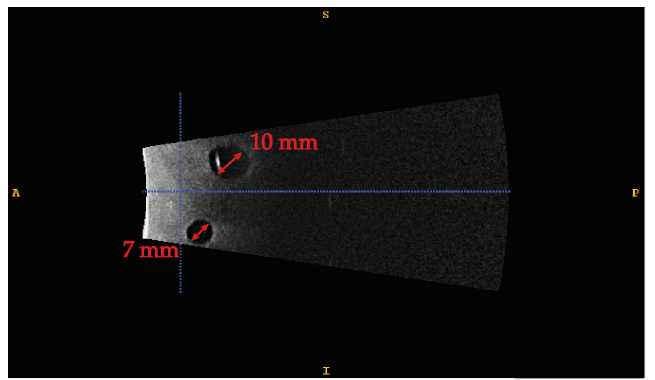
Figure 8. Ultrasound image of the phantom. Two anechoic lesions, 10 and 7 mm, respectively, are detected in the acquired